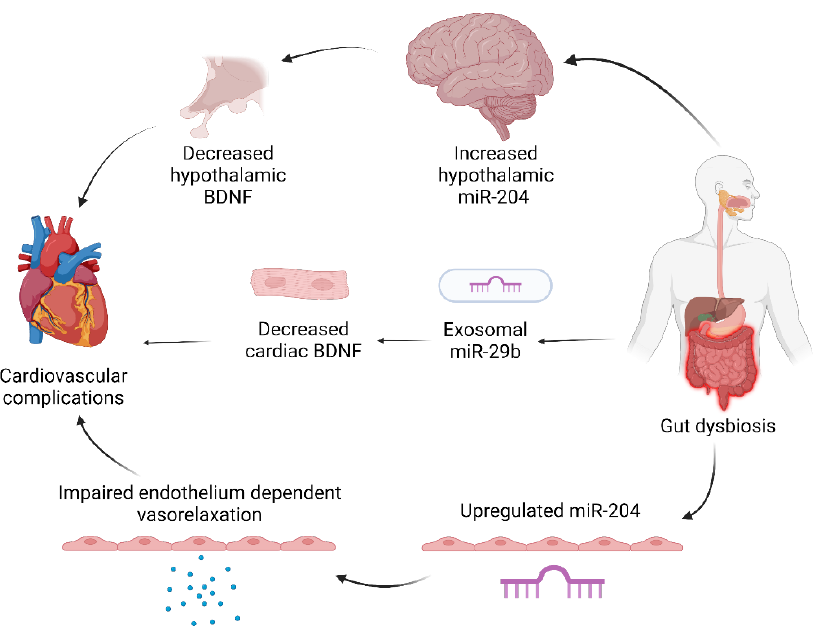
Figure 3. IBD affects the heart through multiple mechanisms. Gut dysbiosis can contribute to cardiovascular complications through affecting indirect neurogenic signaling, directly sending exosomes to modulate cardiac regulators, and impairing vasorelaxation through circulating inflammatory markers. Created with Biorender.